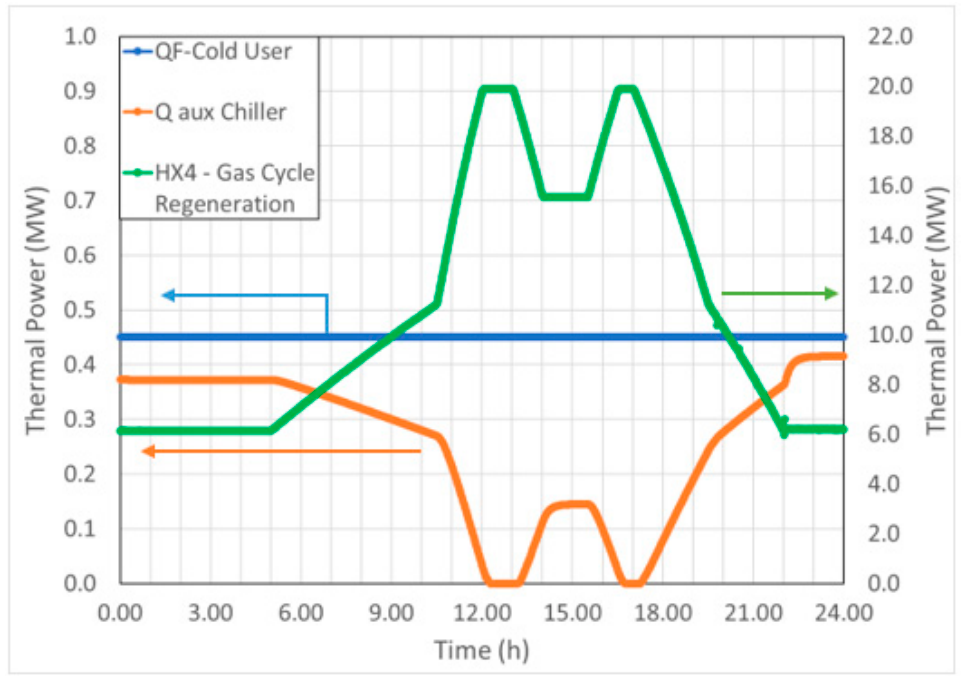
Figure 6. Trends of daily thermal energy production and recovery. The green curve refers to the secondary axis.